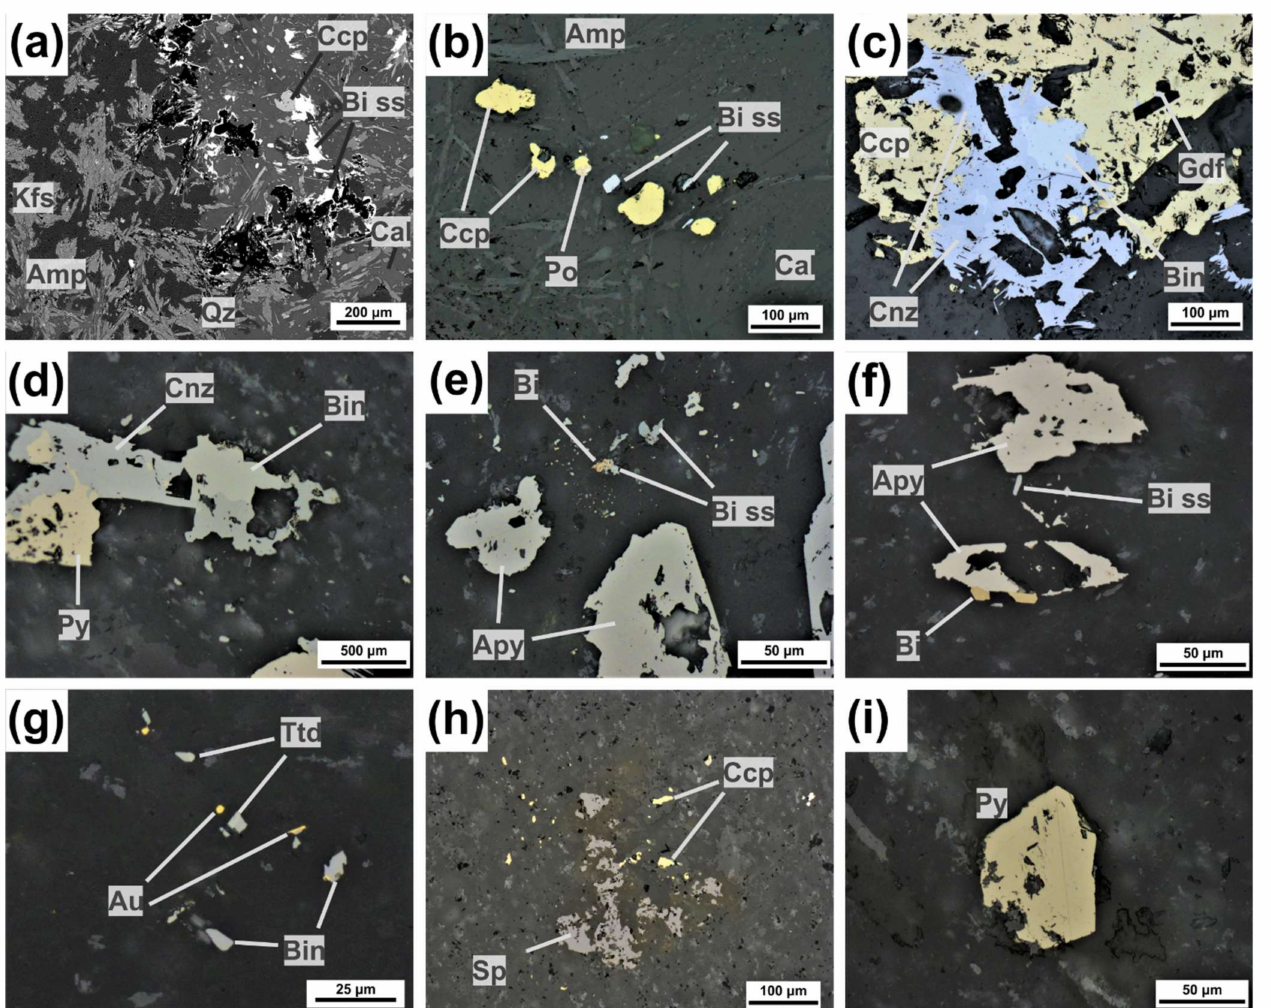
Figure 14. Back-scattered electron (BSE) image ( a ) and reflected-light photomicrographs ( b–i ) of Bi-Au-Cu-Te mineralization from the Kizhnica hornfels: ( a ) irregular aggregates of chalcopyrite and Bi sulfosalts at the contact of calcite with K- feldspar, quartz, and amphibole; ( b ) chalcopyrite associated with pyrrhotite and Bi sulfosalts disseminated in hornfels matrix composed of calcite and amphibole; ( c ) chalcopyrite with cannizzarite–bismuthinite aggregate and gersdorffite inclusion; ( d ) aggregate of cannizzarite with bismuthinite replacing pyrite; ( e ) disseminated native bismuth droplets and bismuth sulfosalts in hornfels matrix near arsenopyrite crystals; ( f ) native bismuth and Bi sulfosalts overgrowing arsenopyrite; ( g ) disseminated tiny crystals of native gold, tetradymite, and bismuthinite; ( h ) sphalerite–chalcopyrite aggregate; ( i ) euhedral pyrite crystal. Abbreviations: Amp = amphibole; Apy = arsenopyrite; Au = native gold; Bi = native bismuth; Bi ss = bismuth sulfosalts; Bin = bismuthinite; Cal = calcite; Ccp = chalcopyrite; Cnz = cannizzarite; Gdf = gersdorffite; Kfs = K-feldspar; Qz = quartz; Po = pyrrhotite; Py = pyrite; Sp = sphalerite; Ttd =